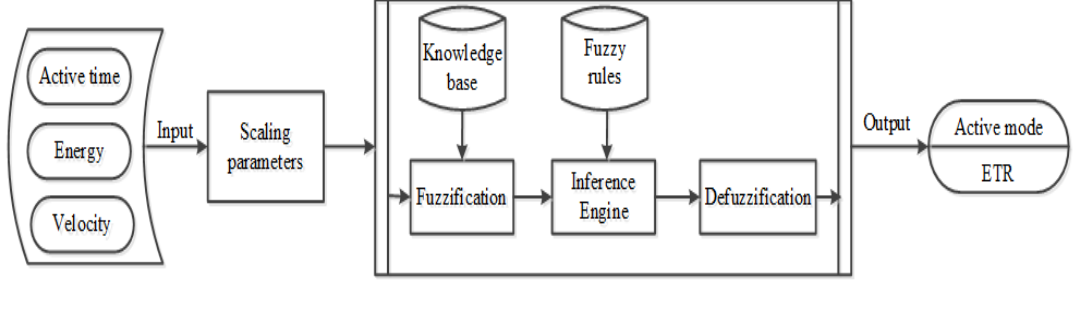
Figure 1. Fuzzy logic controller